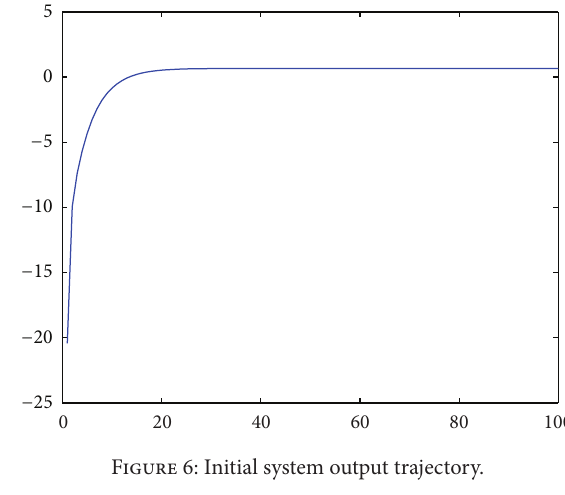
Figure 6: Initial system output trajectory.